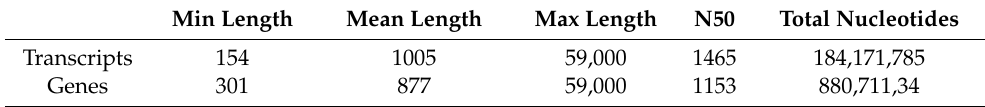
Table 2. Summary of transcriptome splicing length distribution data from T. yunnanensis .